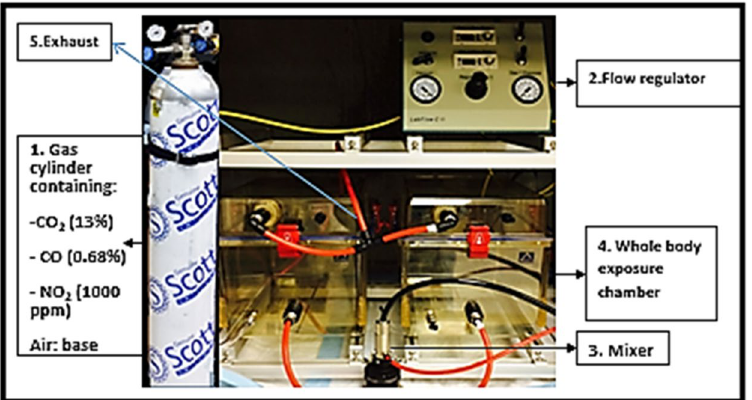
Figure 1. Simulated vehicle exhaust exposure (SVEE) model apparatus. SVEE consists of a whole body exposure system with two chambers fitted with tubing systems to allow inflow and outflow of gaseous mixtures. There is a cylinder that contains simulated mixture of vehicle exhaust. Gaseous mixture from the cylinder is blended with air in the mixer and then flow of the mixture is controlled using a flow regulator. Rats were subjected to SVEE in this